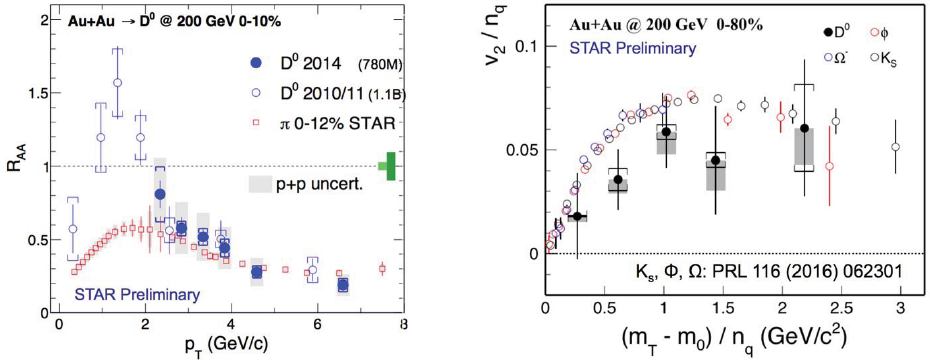
Figure 1. (Color online) Nuclear modification factor R AA [4] (left) and elliptic anisotropy (right) [5] of D 0 mesons in Au + Au collisions, compared to those of other